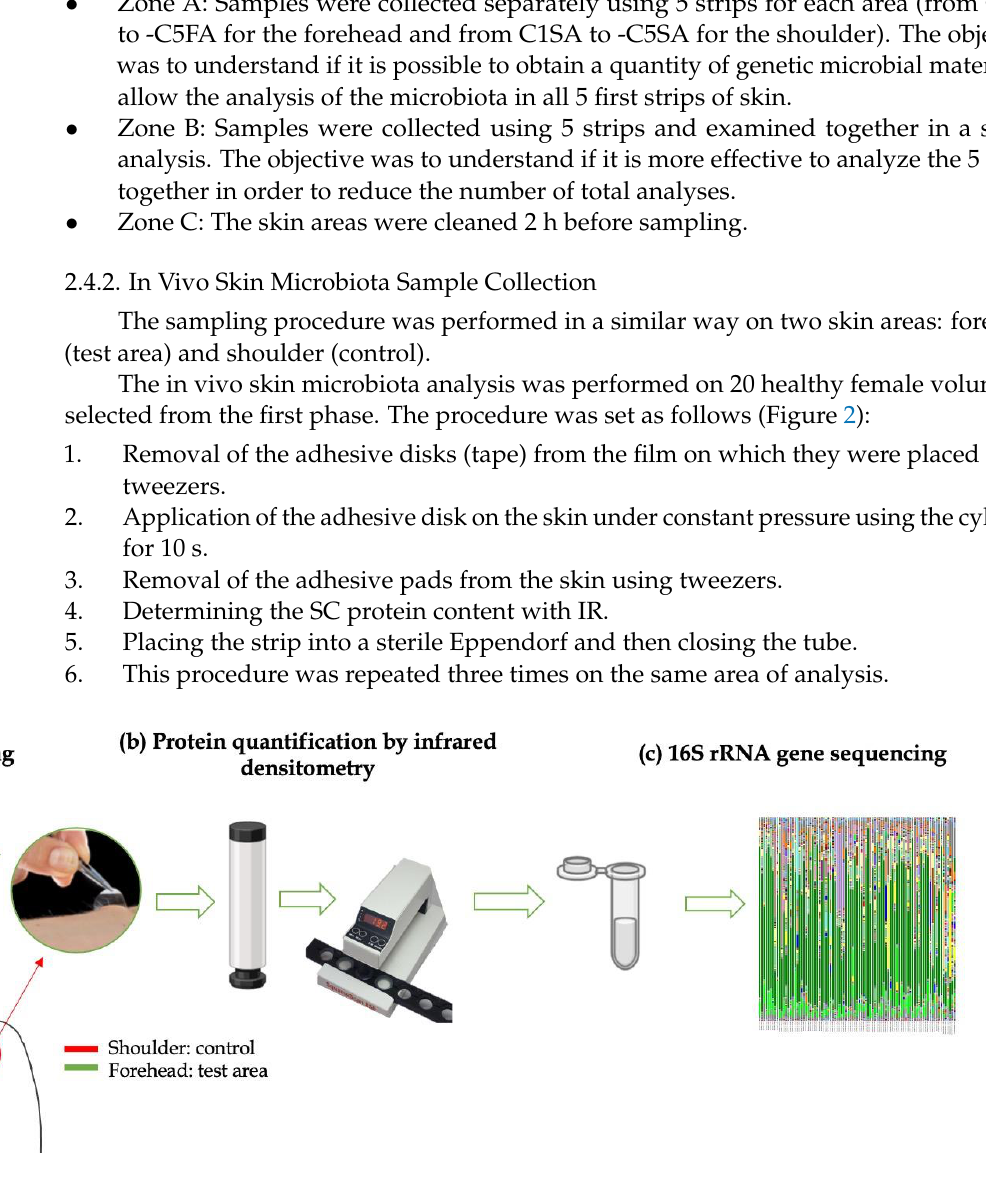
Figure 2. Schematic representation of skin microbiota analysis in in vivo study: ( a ) microbiota col- lection using tape-stripping on the forehead (green) and shoulder (red) areas; ( b ) protein quantification on tapes collected; ( c ) microbiota analysis on the same tapes collected (figure set up with PowerPoint software).